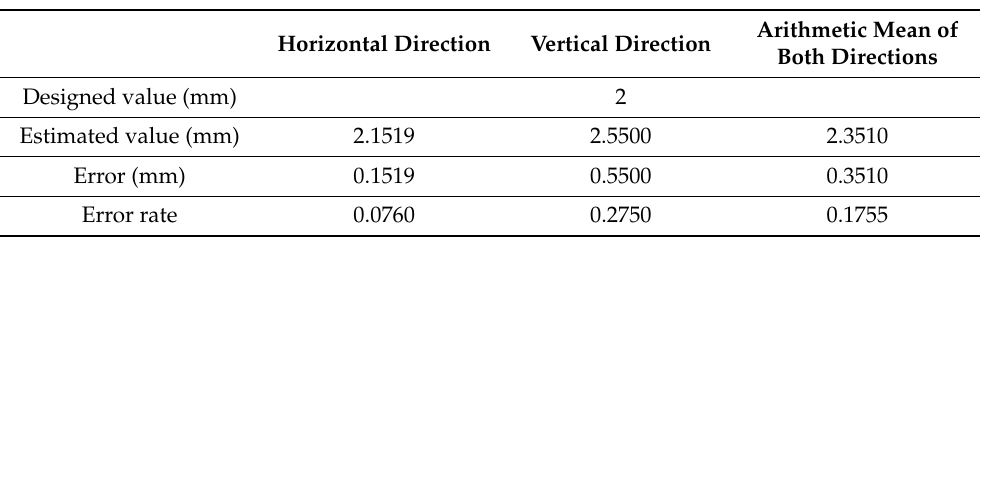
Table 6. GSD accuracy of the